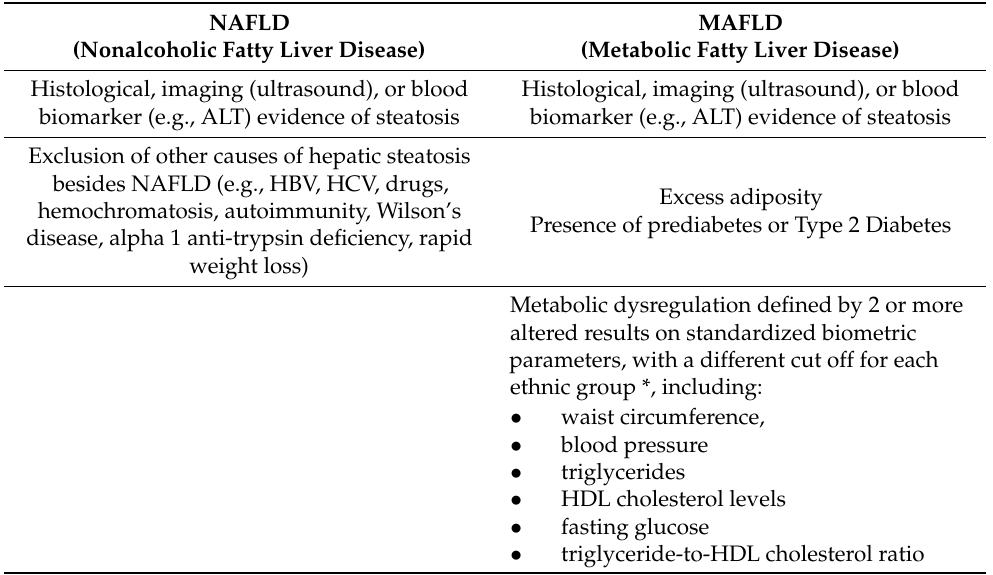
Table 1. Diagnostic criteria of NAFLD and MAFLD. NAFLD (Nonalcoholic Fatty Liver Disease)